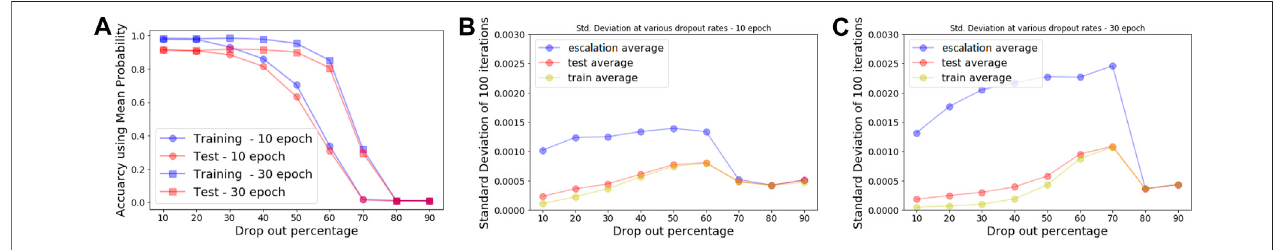
FIGURE 4 | Classi fi cation accuracy and uncertainties obtained from Monte Carlo dropout.